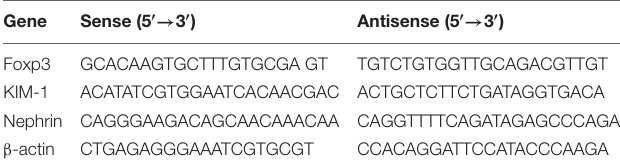
TABLE 1 | The sequences of primers used for